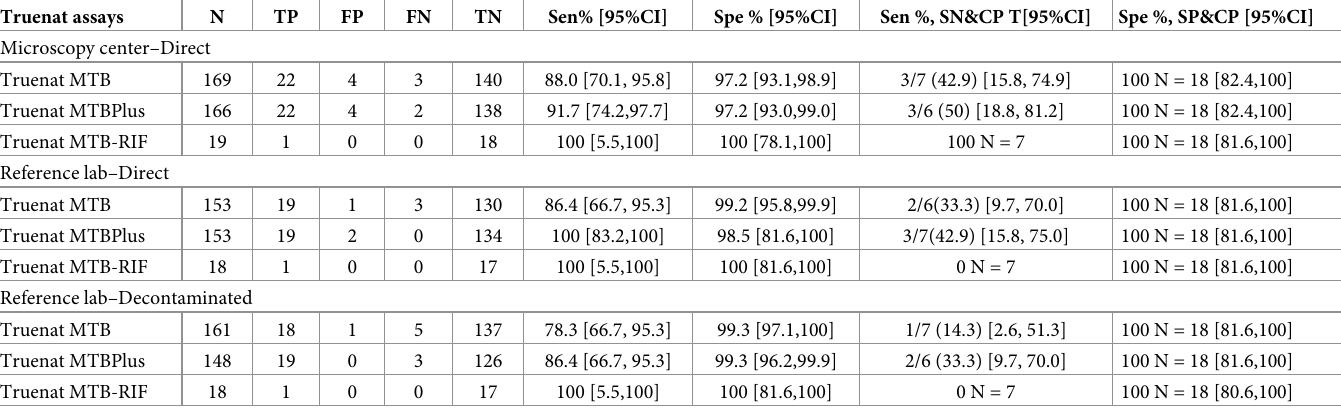
Table 1. Diagnostic accuracy of the Truenat assays for MTB detection and MTB-RIF resistance detection among 200 enrolled